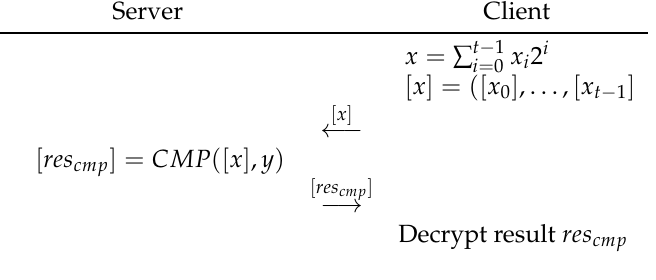
Figure 1. Integer-comparison